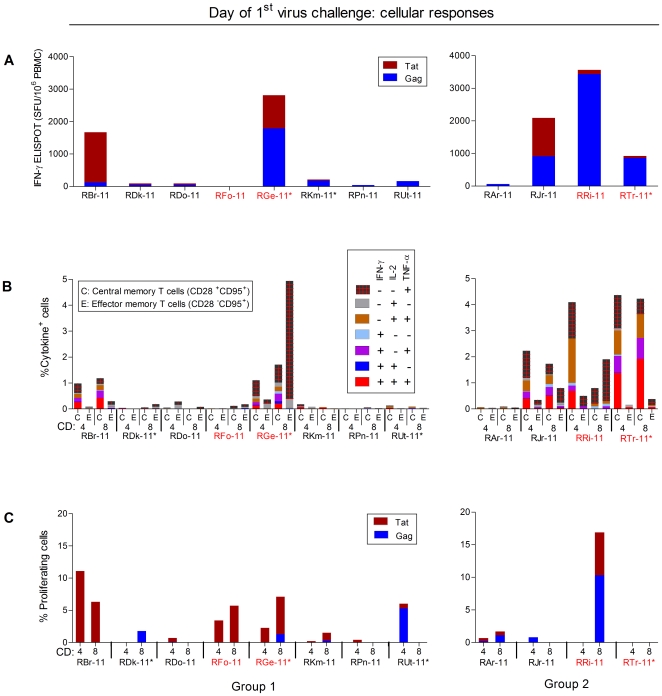
Cellular immunity at the time of initial low-dose SHIV-1157ipEL-p challenge.(A) The frequency of antigen-specific cells measured by IFN-γ ELISPOT assay. No responses were seen in control Group 3. (B) The frequency of SIV Gag and HIV-1 Tat-specific peripheral blood CD4+ and CD8+ T cells producing intracellular IFN-γ, IL-2 and TNF-α was measured using multiparameter flow cytometry. (C) Proliferation of peripheral blood CD4+ and CD8+ T cells in response to SIV Gag or HIV-1 Tat proteins. *, Mamu A*001-positive RM.